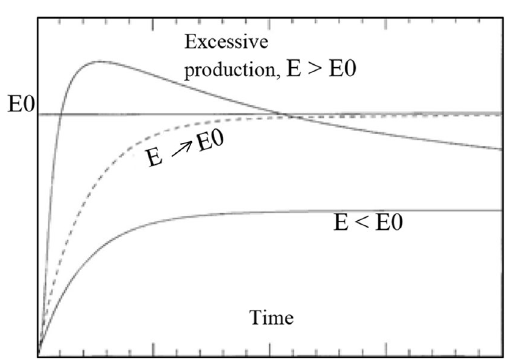
Fig. 1 Schematic illustration of the difference between sustainable and excessive production. (Source Steingrimsson 2006: 4)